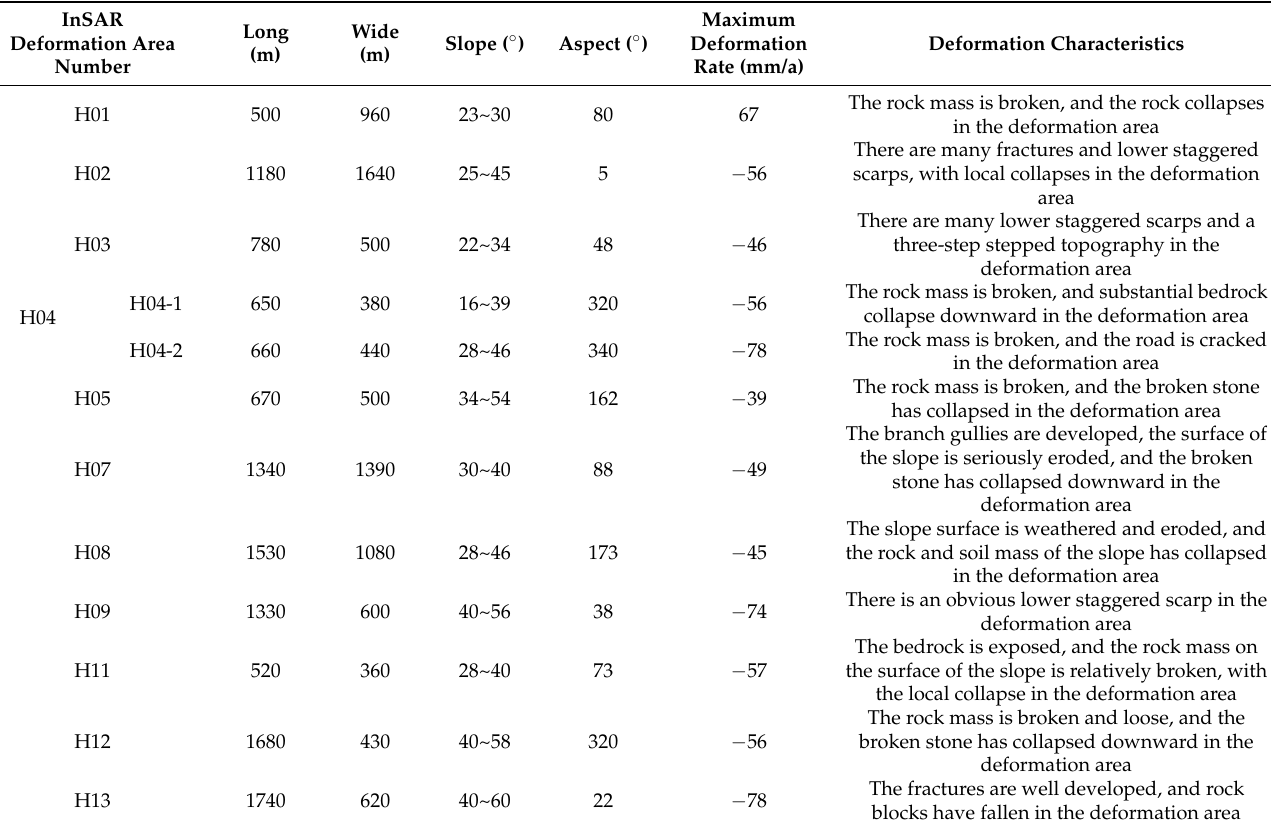
Table 3. Summary of information regarding active